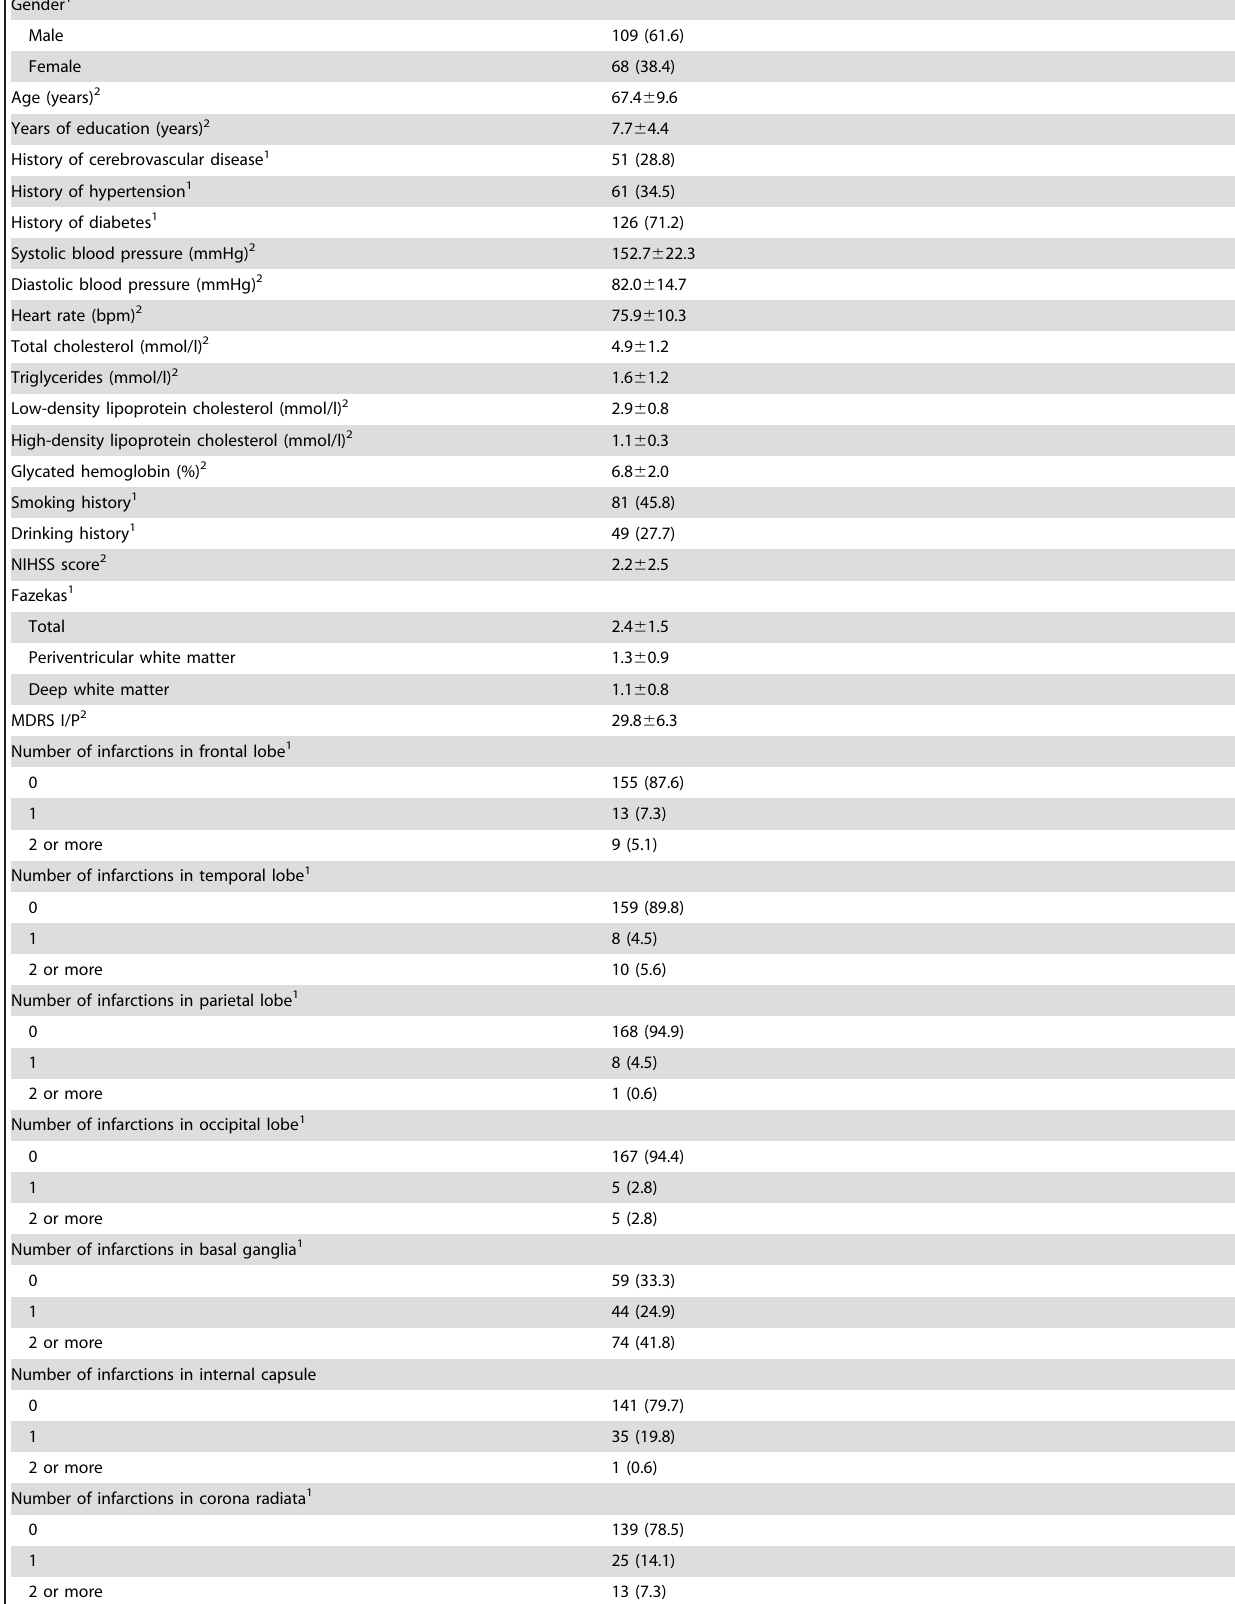
Table 1. Summary of patient data